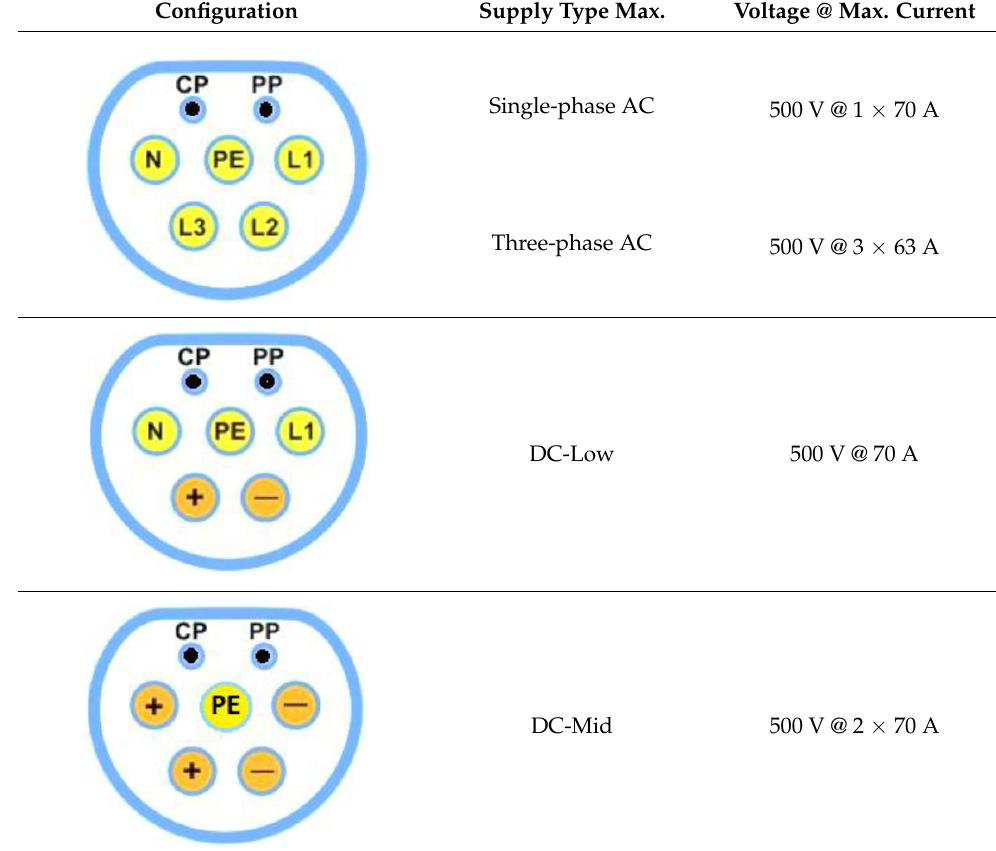
Figure 13. Signaling circuit in a J1772 interface. Table 6. AC and DC available configurations of Type 2 EV Inlet. Configuration Supply Type Max.